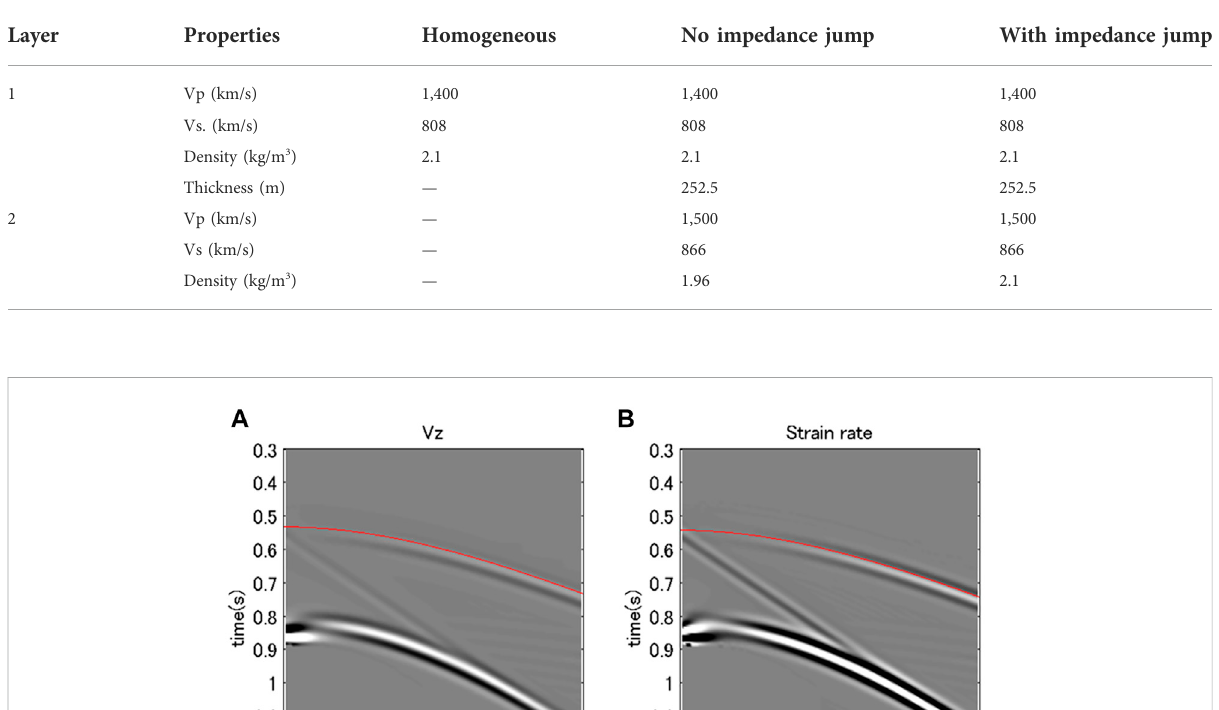
TABLE 1 Summary of the synthetic models.